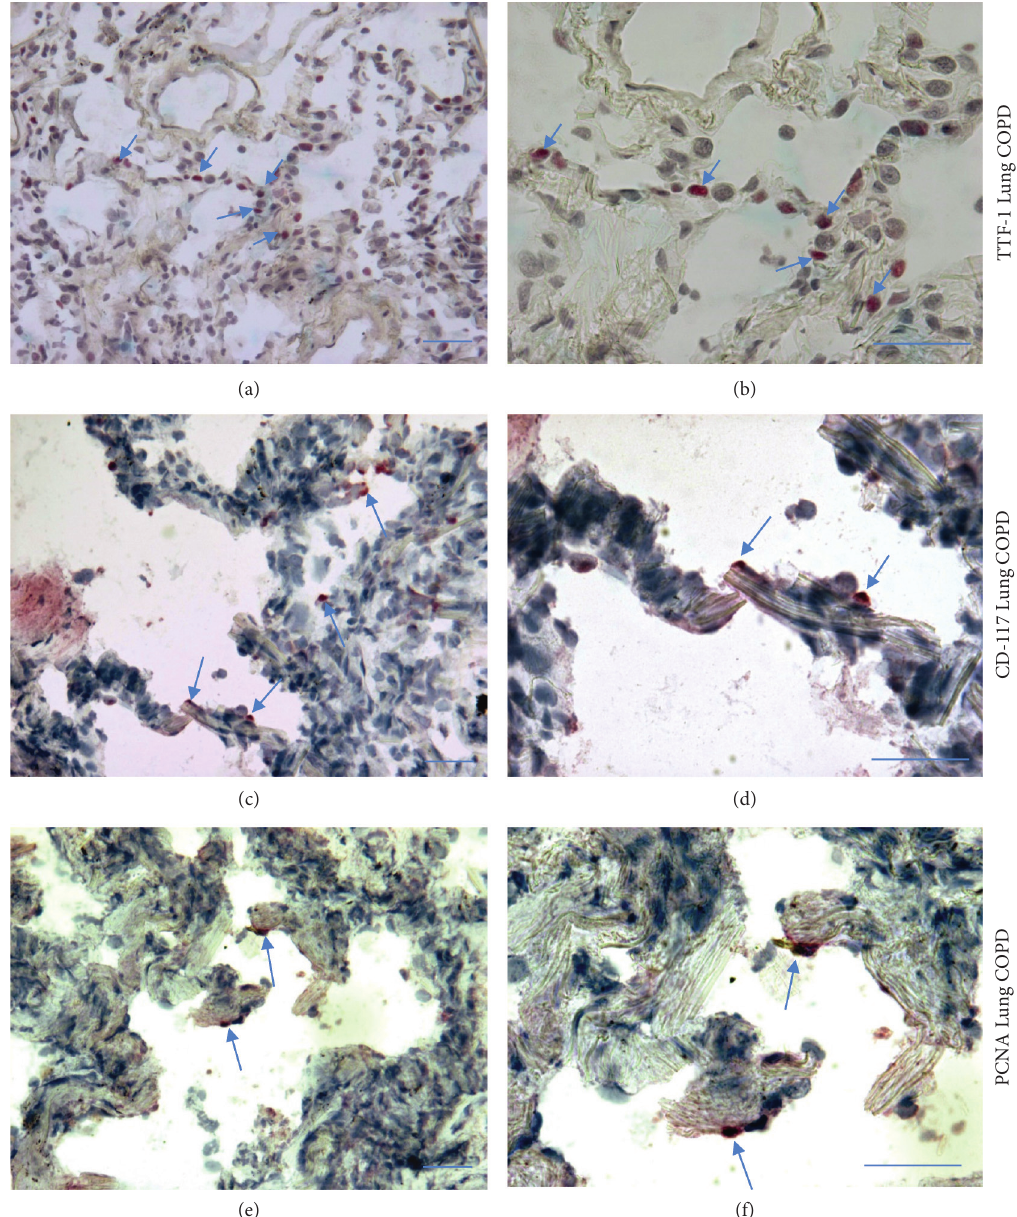
Figure 8: Photomicrographs showing thyroid transcription factor-1 (TTF-1) expression (panels a, b), c-Kit (CD117) (c, d), and proliferating cell nuclear antigen (PCNA) (e, f) in the peripheral lung tissue of a representative patient with chronic obstructive pulmonary disease (COPD). Arrows indicate positively stained cells mainly located in the alveolar septa. Bars � 50